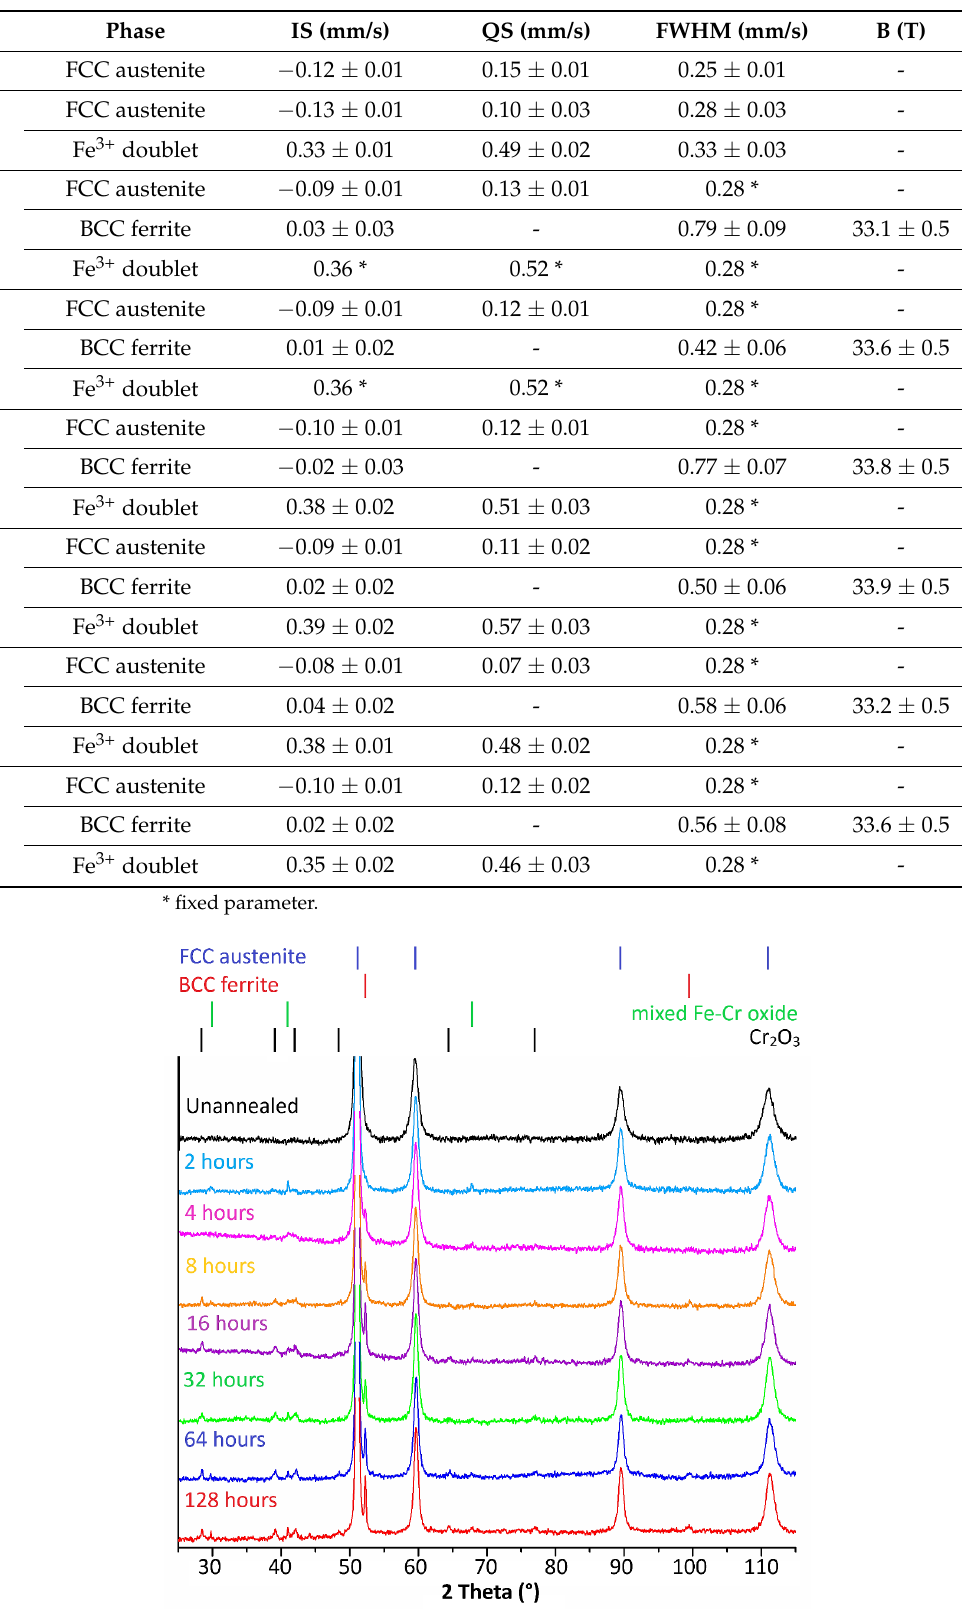
Figure 8. X-ray diffraction patterns of annealed samples.